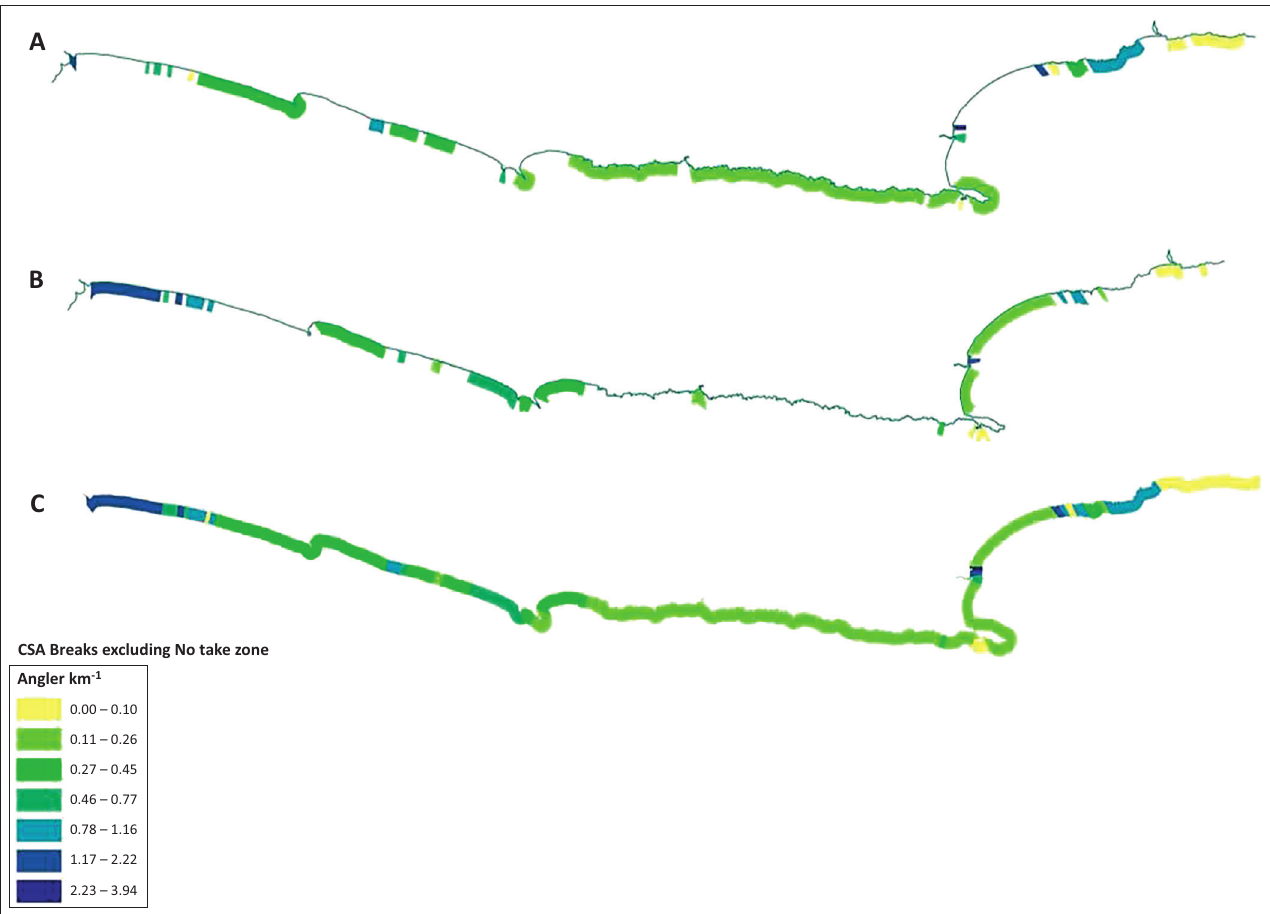
FIGURE 4: The distribution of total angling effort (anglers.km -1 ) between the Kaaimans River in the west and the western border of the no-take Tsitsikamma Marine Protected Area between rocky areas (A), sandy areas (B) and both rocky and sandy areas combined